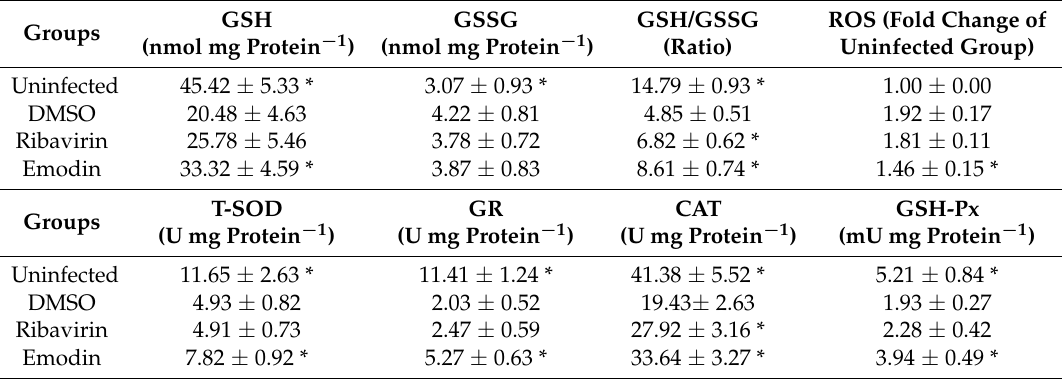
Table 1. Inhibition of emodin on IAV-induced oxidant stress.